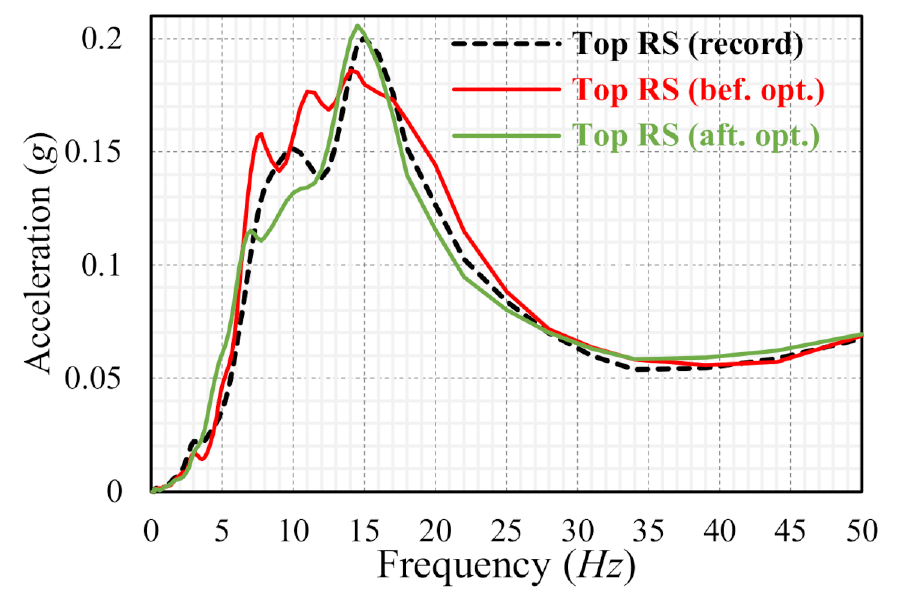
Figure 10. Comparison response spectrum of the apex point of the CGD before and after optimization.